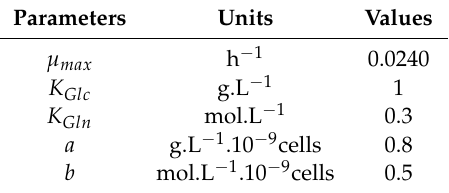
Table 2. Model parameter